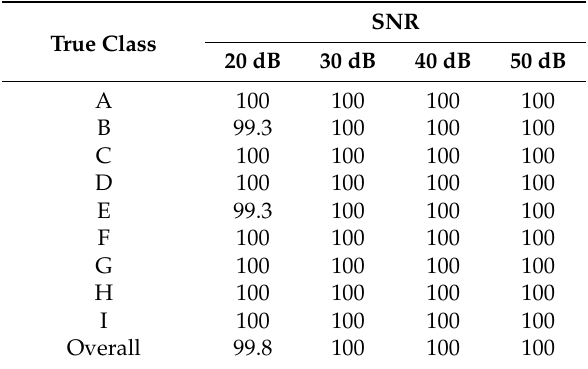
Table 5. Classification accuracy at different levels of signal to noise ratio